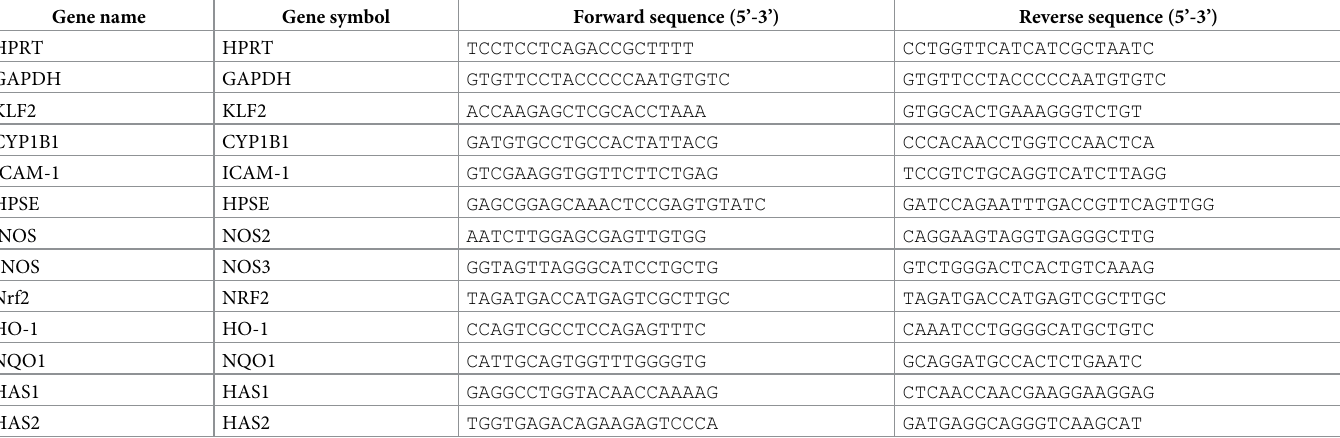
Table 1. Overview of the primers used in this study. Gene